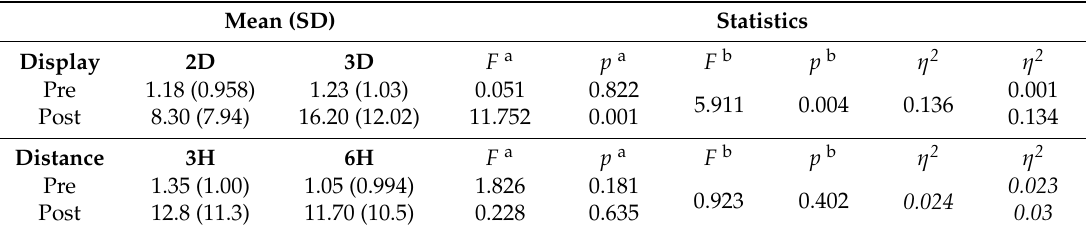
Table 2. Score means (standard deviation) for total subjective visual discomfort